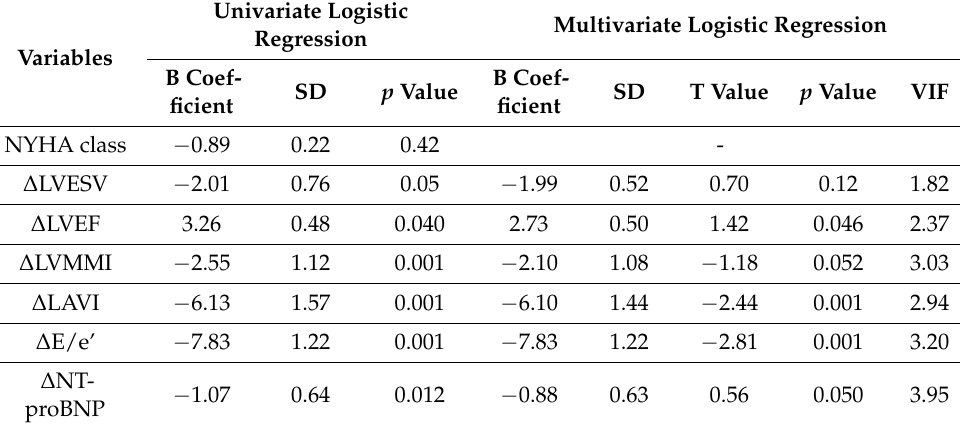
Table 3. Univariate and multivariate logistic regressions analysis for the association of apelin levels with NYHA class, and relative changes in hemodynamics and NT-proBNP.